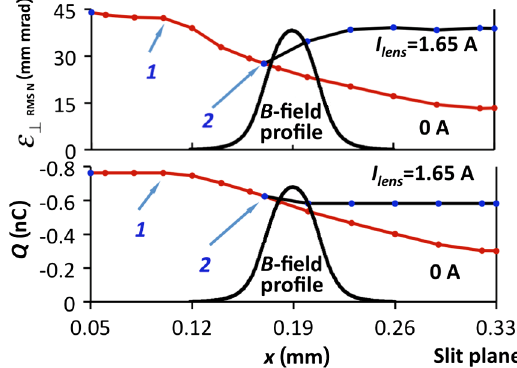
FIG. 12. Simulation of the emission measurements at ¼ (cid:2) 32 kV . Normalized rms transverse emittance (top) V cathode and bunch charge (bottom) as a function of axial position for ¼ 1 : 65 A and I ¼ 0 A . Particles begin hitting the wall at I lens lens the point labeled 1 and the magnetic field begins to affect the emittance at the point labeled 2. The normalized magnetic field profile of the lens is also shown.